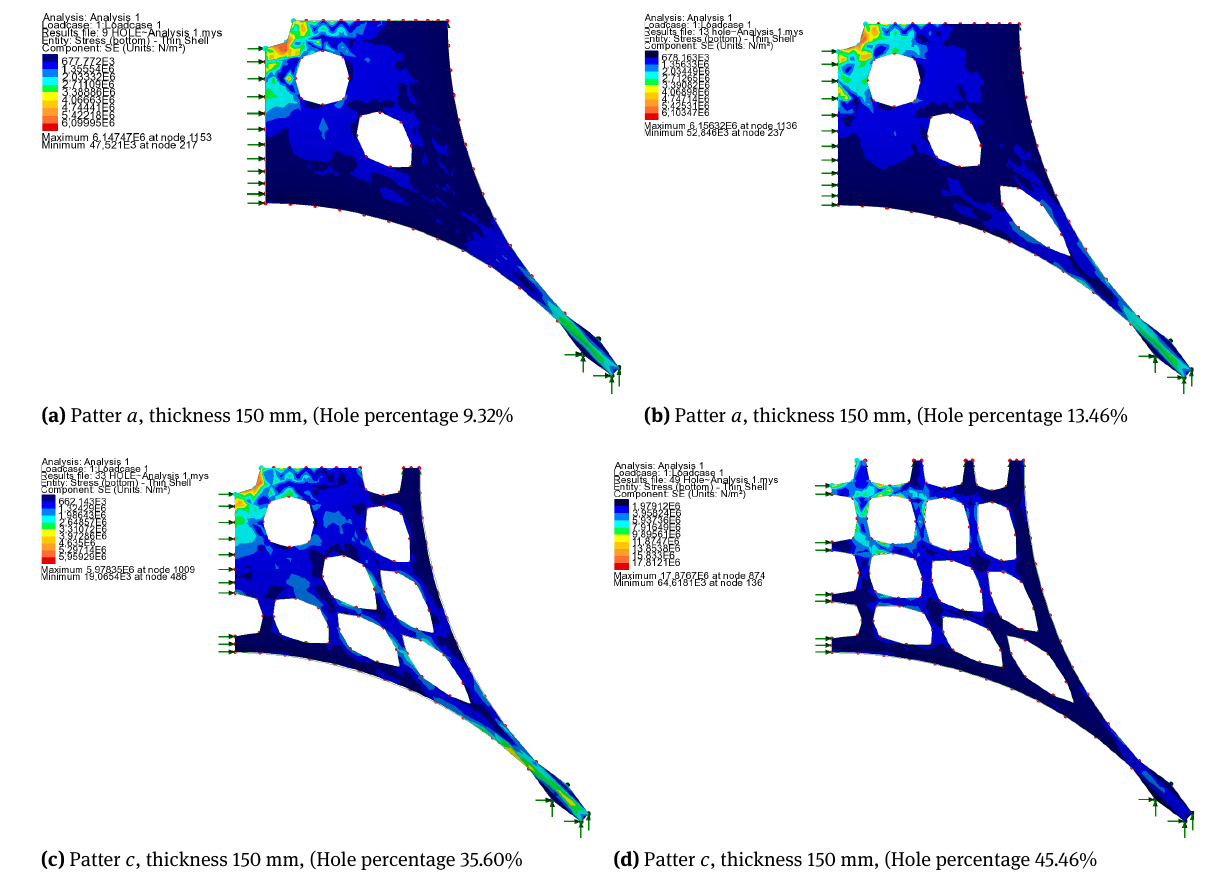
Figure 4: In this figure some of the most representative results in terms of stress field are reported. Von Mises stress plots for pattern a are represented in the cases of hole percentages equal to 9.32% (a) and 13.46% (b) (steps with 9 and 13 holes). Similar results are reported for pattern c in the cases of hole percentages equal to 35.60% (c) and 45.46% (d) (steps with 33 and 49 holes)